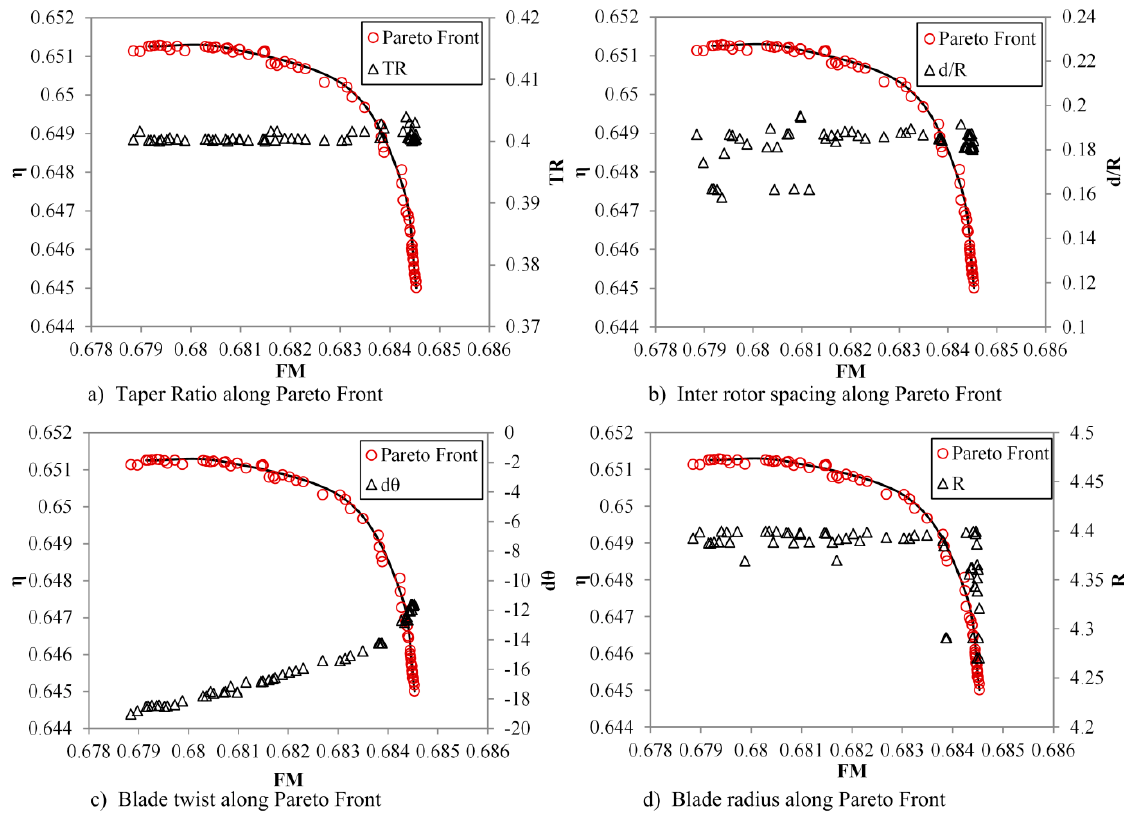
Figure 14. Multi-objective optimization results based on NSGA-II (20 generations).